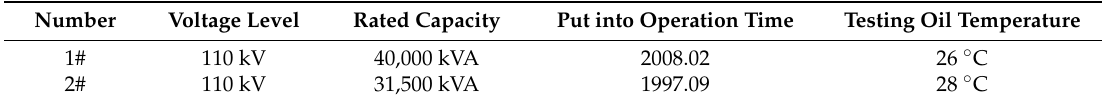
Table 6. Specific information of field transformers.